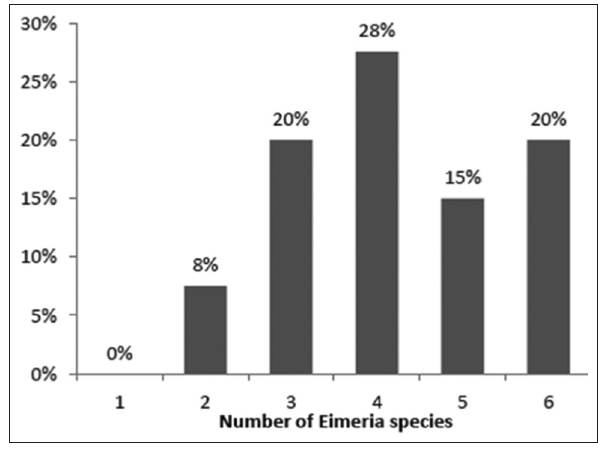
Figure-2: Percentage of mixed infections with different Eimeria species in Algerian rabbit Table-1: Regional prevalence of coccidian infection in Algerian rabbit farms.